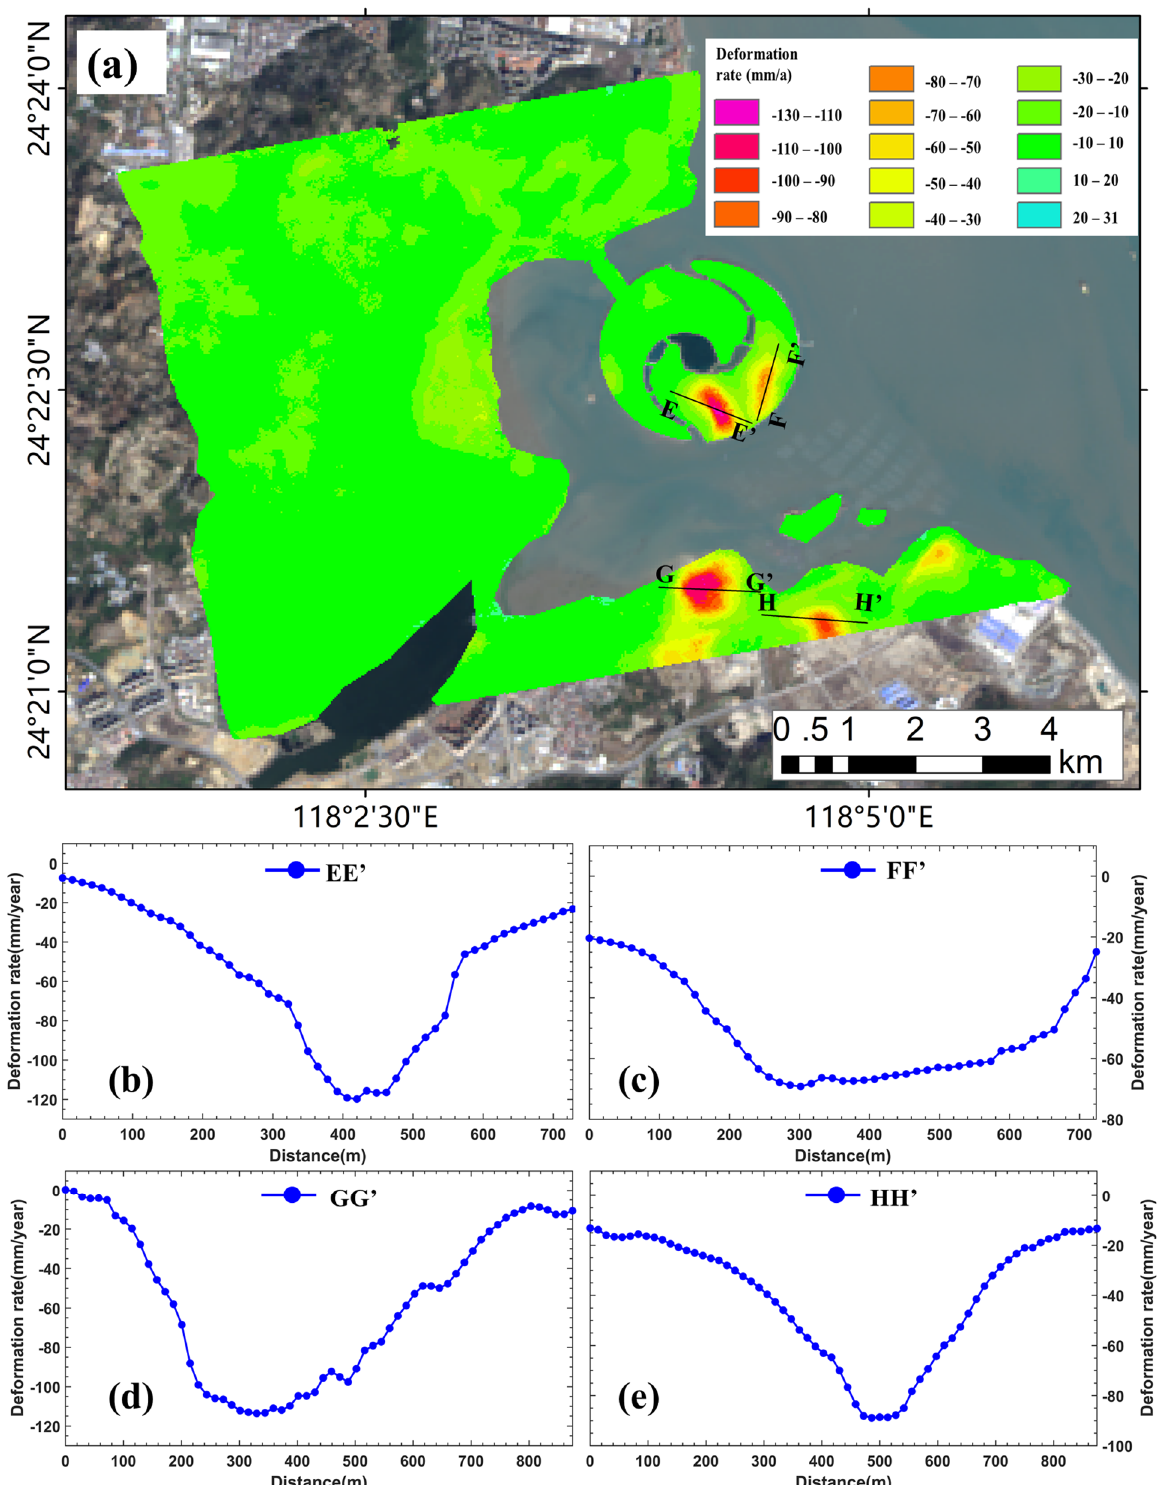
Figure 7. ( a ) Annual vertical deformation rate map of Shuangyu Island. Cross-sections of the annual vertical deformation rate of Shuangyu Island along four profiles, whose positions are marked in Figure 7a; ( b ) profile E–E’; ( c ) profile F–F’; ( d ) profile G–G’; ( e ) profile H–H’.